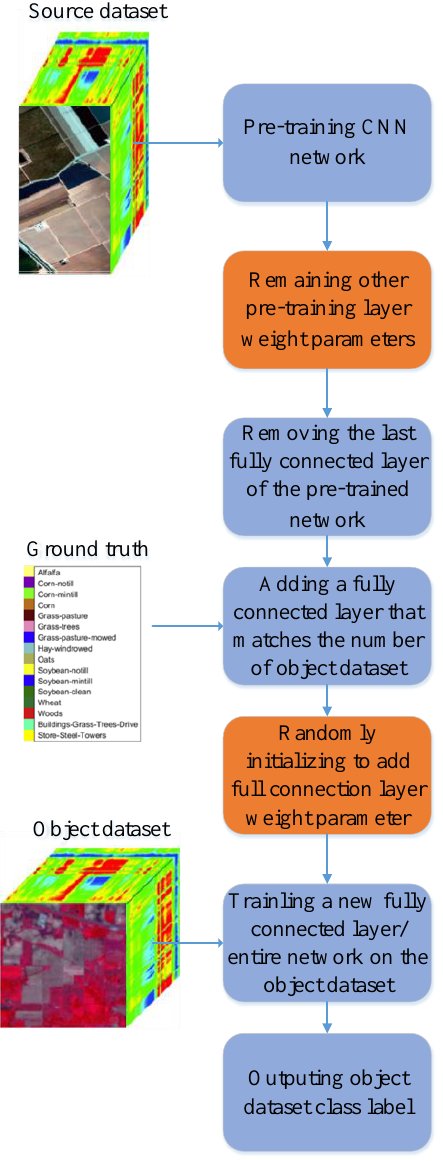
Figure 7. Hyperspectral image classification process based on deep transfer learning.